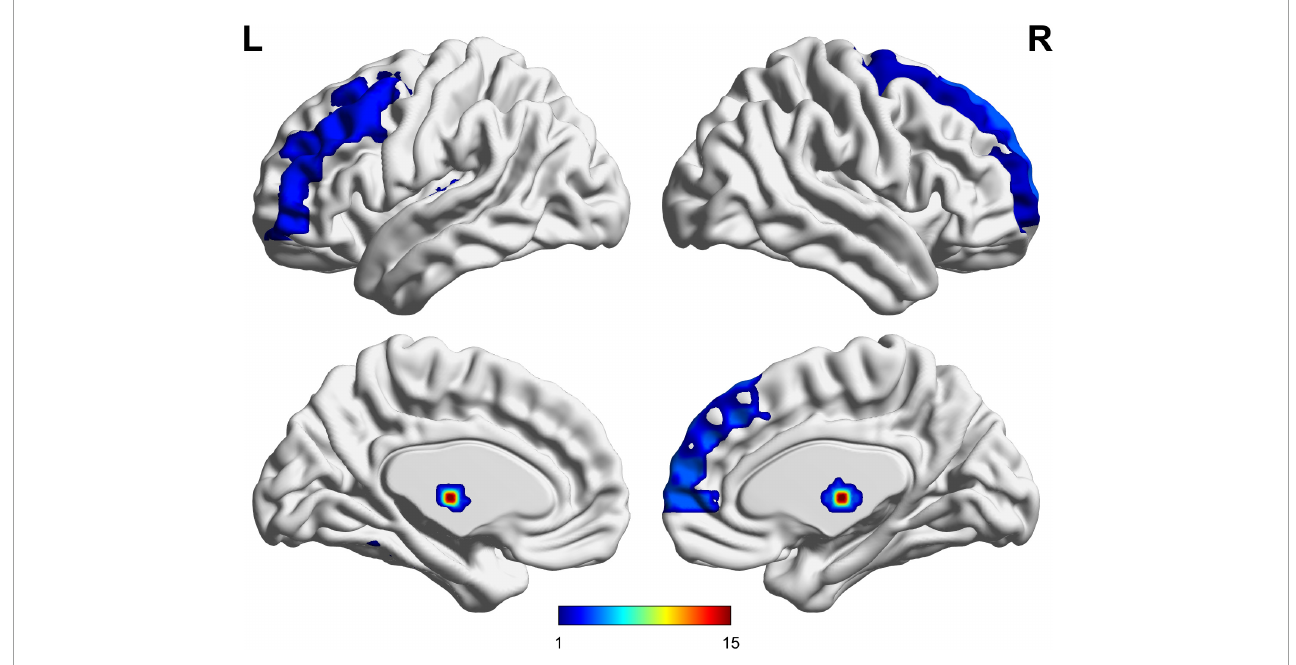
FIGURE2 Functional region of interests (ROIs) used in the